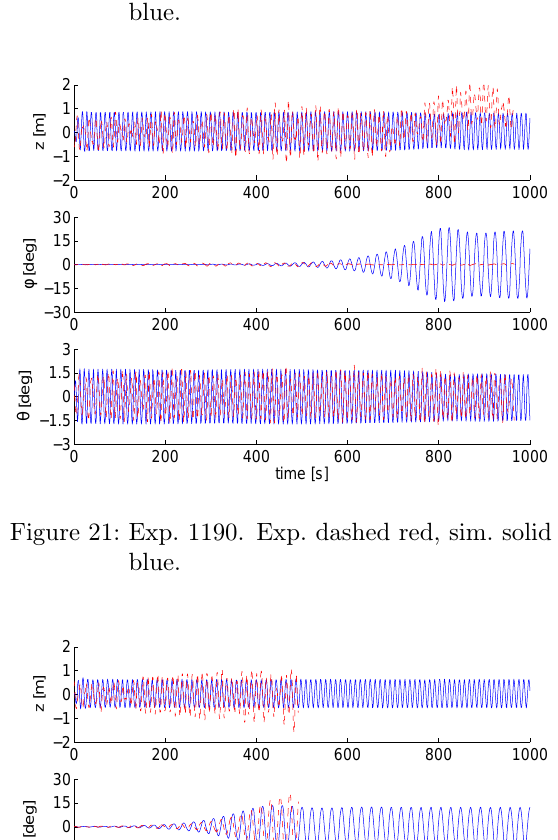
Figure 20: Exp. 1192. Exp. dashed red, sim. solid blue.